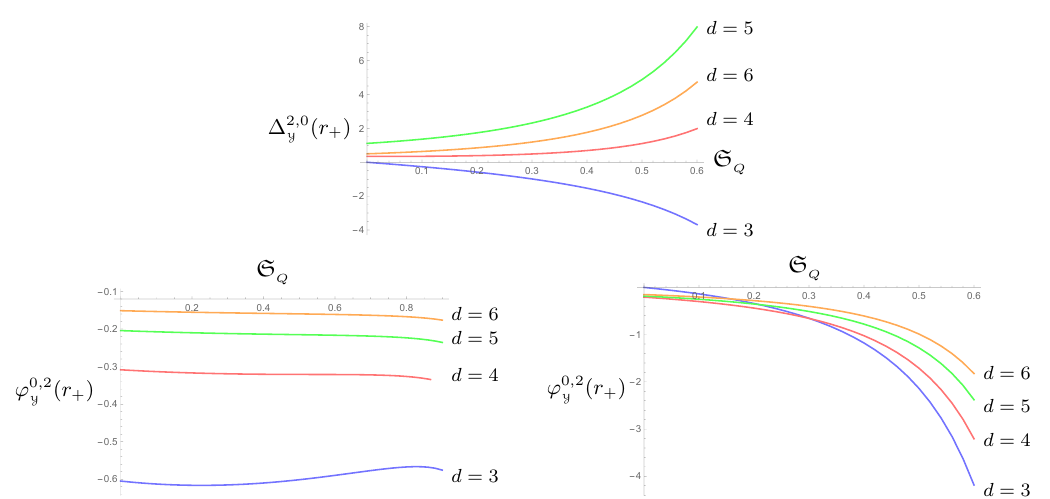
Figure 3 . The charge dependence of the coefficients in Green’s function of the Markovian vector polarizations encoded in Y in dimensions d = 3 , . . . , 6 . We use the Ohmic radius S defined in α Q eq. (2.9) as the proxy for the charge reminding the reader that S = 0 corresponds to the neutral Q Schwarzschild-AdS black hole while S → 1 is the extremal limit (where the various functions d +1 Q diverge).